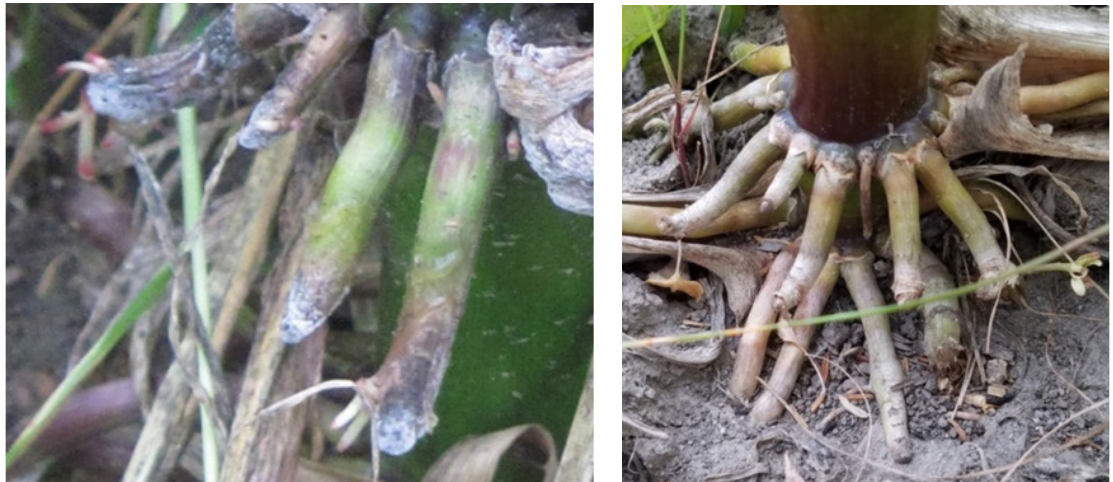
Figure 9: Picture at the top shows inoculated plant of the of the C4-6 subfamily with autolyzing root tips in 2014 in the Goldstein Garden. Picture at the bottom shows non-inoculated plant without autolyzing root tips of a C4-6 derivative line grown on the Rohrer Farm in